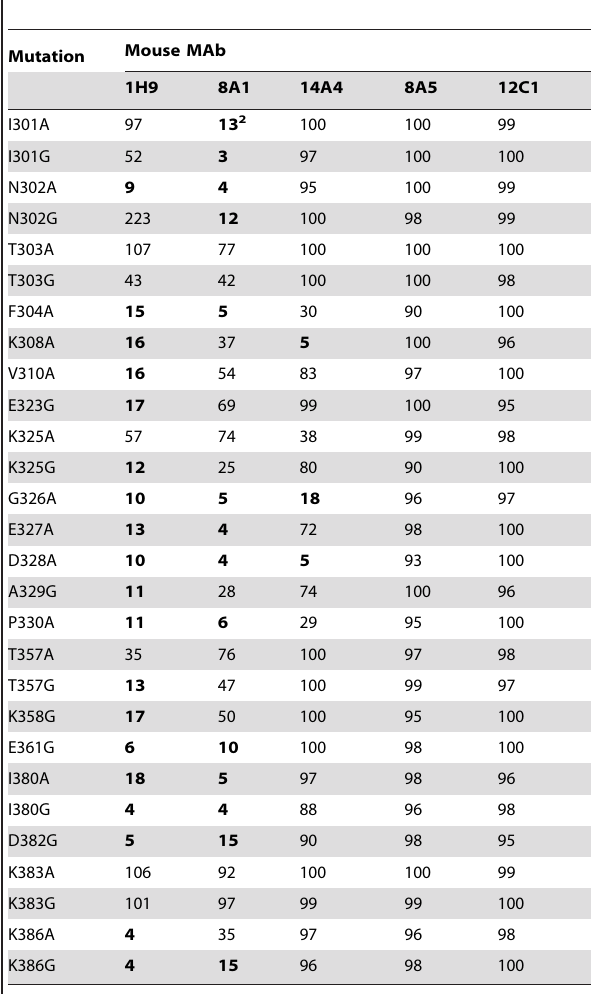
Table 2. Binding 1 of mouse MAbs to mutant DENV3 EDIII proteins.